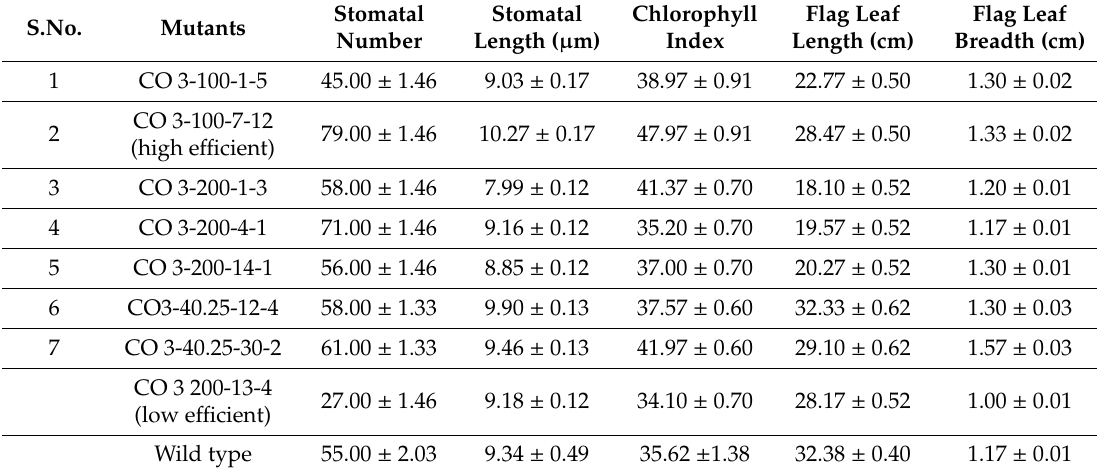
Table 2. Mutants screened for photosynthetic e ffi ciency in M 2